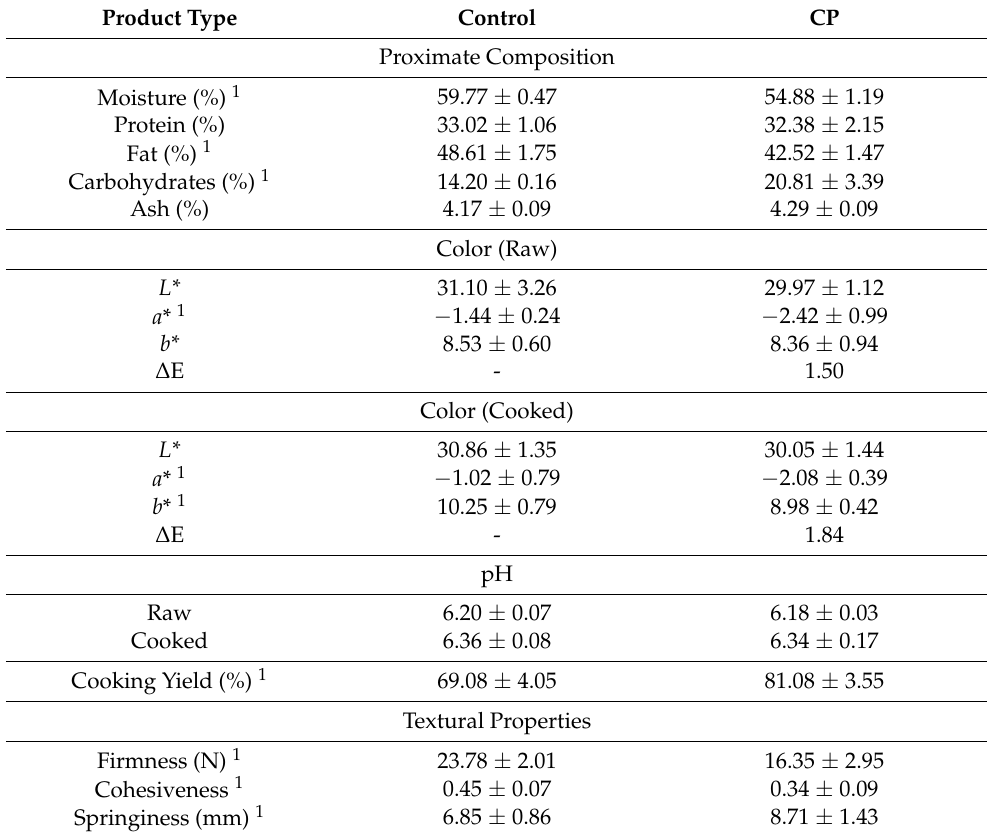
Table 4. Proximate composition of the raw sausage (on a dry basis), color, pH, cooking yield, and textural properties of both sausages developed. The means with 95% confidence intervals are shown. All percentages were rounded to the nearest hundredth place. Parameters that were denoted were found to be significantly different ( p <